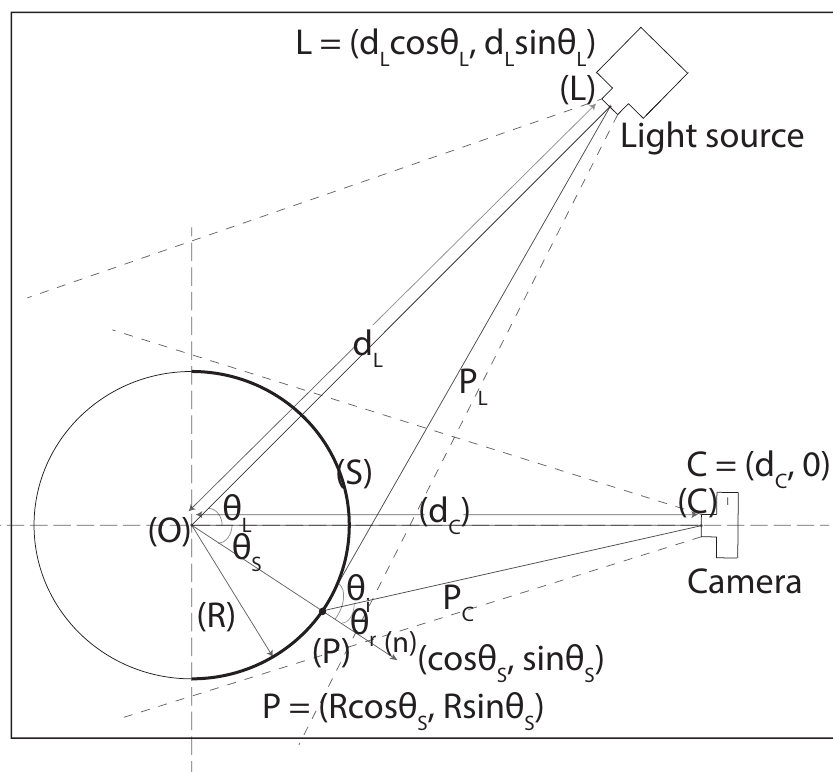
Figure 3. Measurement setup in a vector plane (reprinted with permission of IS&T: The Society for Imaging Science and Technology, sole copyright owners of CIC22: Twenty-second Color and Imaging Conference)